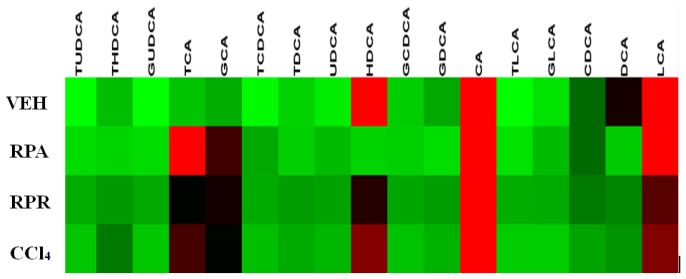
Heat map of bile acids in serum from rats of the CCl4, RPR, RPA, and VEH groups collected at 24 h after intraperitoneal injection of CCl4. (The concentrations of the bile acids are represented by colors ranging from light green to dark red. LCA, GCA, TCA, TCDCA, TDCA, and TLCA were significantly altered among groups and showed the recovery potential of the TCM-treated groups).